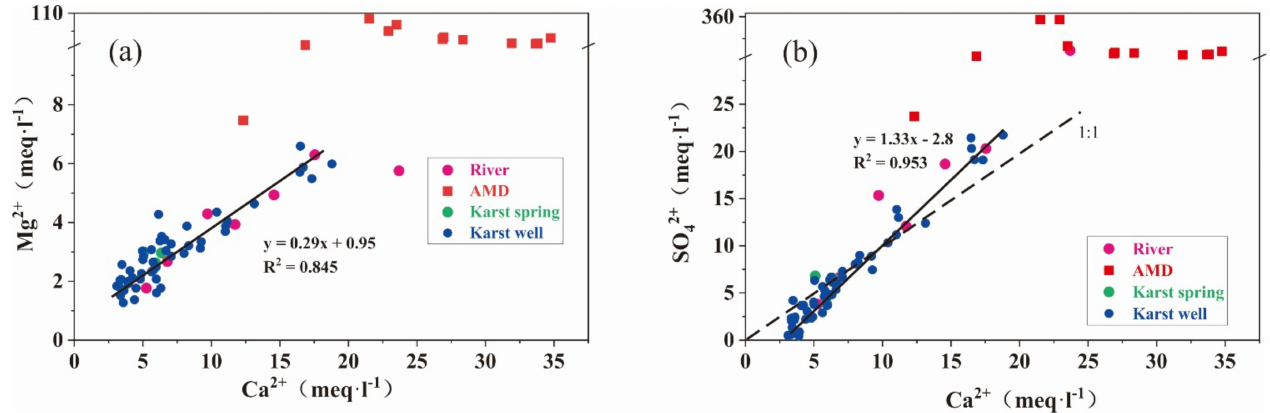
Figure 10. ( a ) Relationships between Mg 2+ vs. Ca 2+ ( b ) Relationships between SO 42+ vs. Ca 2+